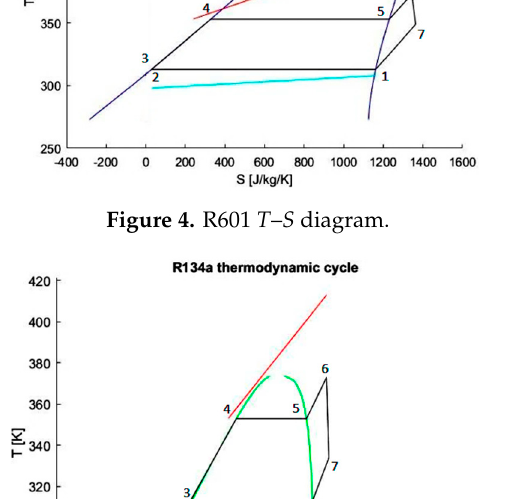
Figure 4. R601 T – S diagram. Table 2. R601 thermodynamic parameters.